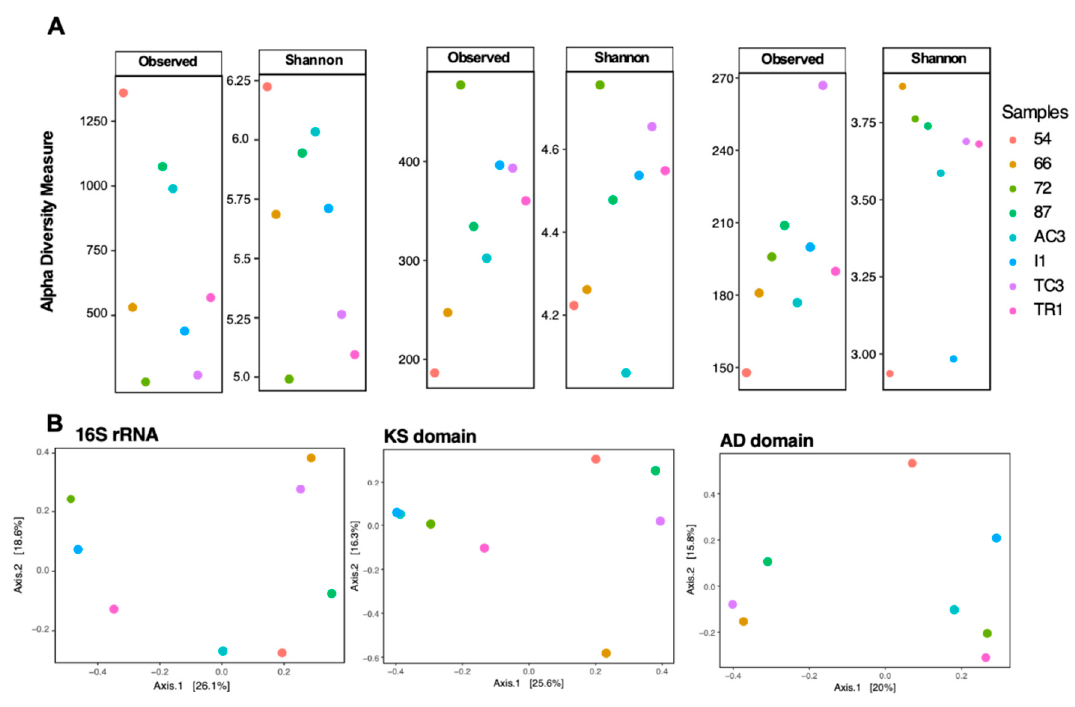
Figure 2. Alpha ( A ) and beta-diversity ( B ) metrics for 16S rRNA gene, ketosynthase (KS) and adenylation (AD) domains. Alpha diversity metrics used were number of amplicon sequence variants (ASVs) and operational domain units (OTUs) (grouped at 97% and in a second round at 95%) and Shannon diversity index.